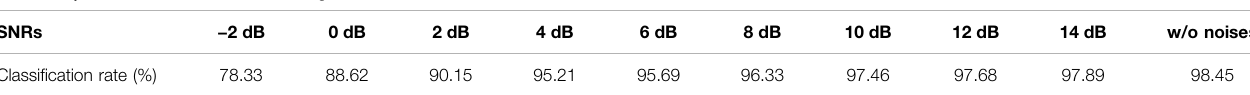
TABLE 6 | Performance with difference degrees of